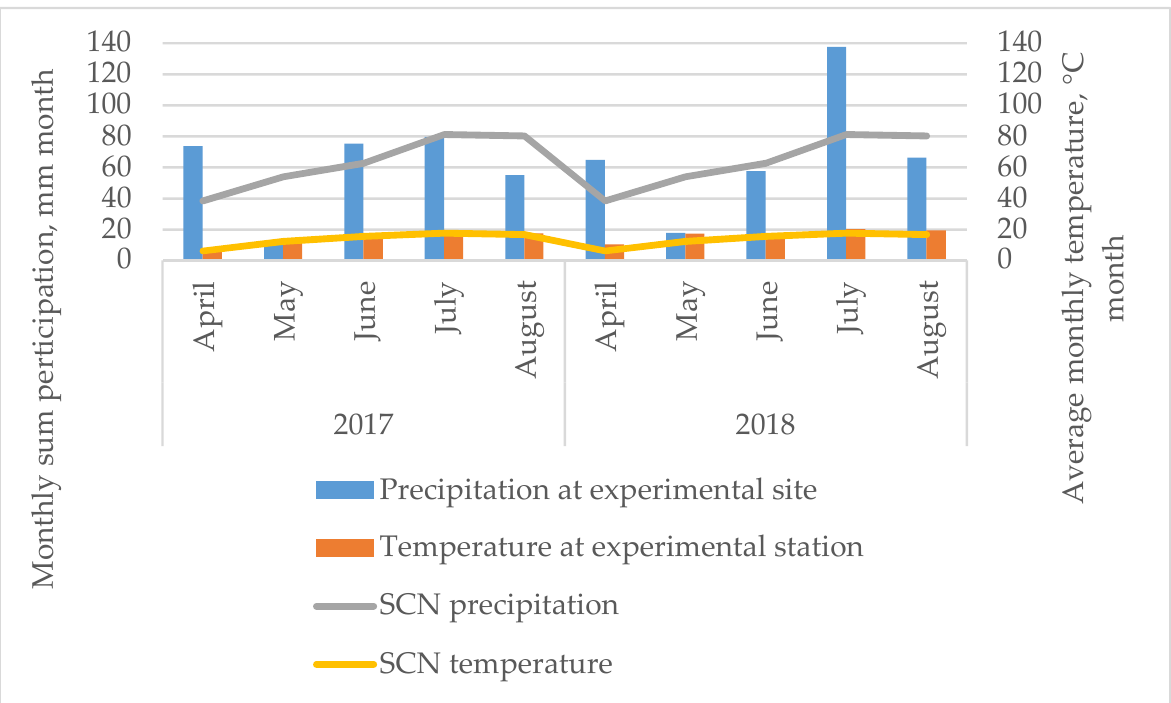
Figure 5. Monthly mean precipitation and temperature at the experimental sites. SCN—standard climate norm, average data for 39 years (1974–2013).